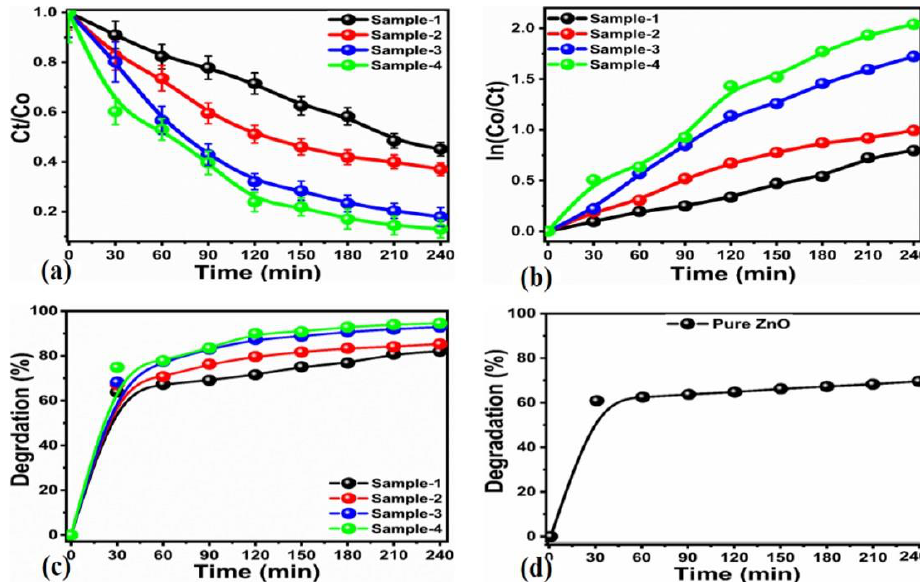
Figure 6. Degradation kinetics ( a ) kinetics C t / C o irradiation time, ( b ) Ln C t / C o plot, ( c ) percent degradation of MB, ( d ) degradation percentage of pure ZnO over